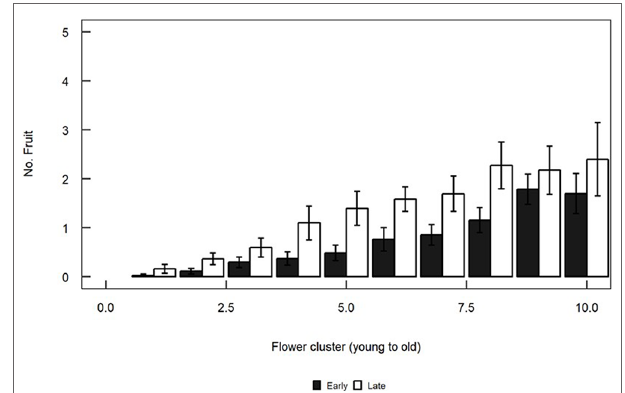
FIGURE 6 | Mean (+/- SE) numbers of fruit per flower cluster in Early (black) and Late (white) trees. Clusters are numbered from distal (youngest) to proximal (oldest). Fruits were counted in five branches of each of the flowering trees in the Shoket population. Only means for clusters which are based on counts of >50 branches (clusters 1–10) are